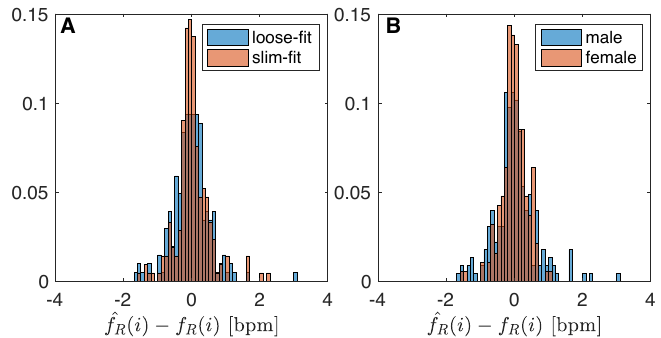
Figure 4. Difference distribution: ( A ) influence of clothing type (i.e., slim-fit vs loose-fit); ( B ) influence of sex (i.e., male vs